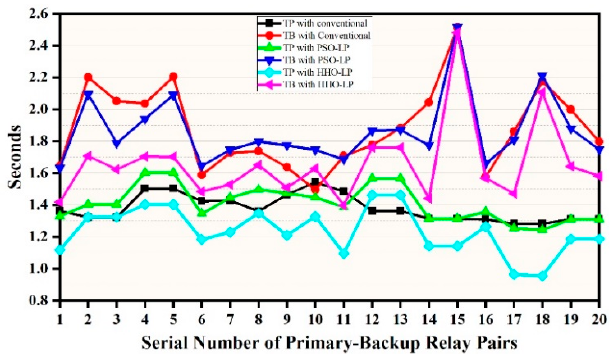
Figure 14. Primary and backup relay pairs as a function of operation time with a wind speed of 20